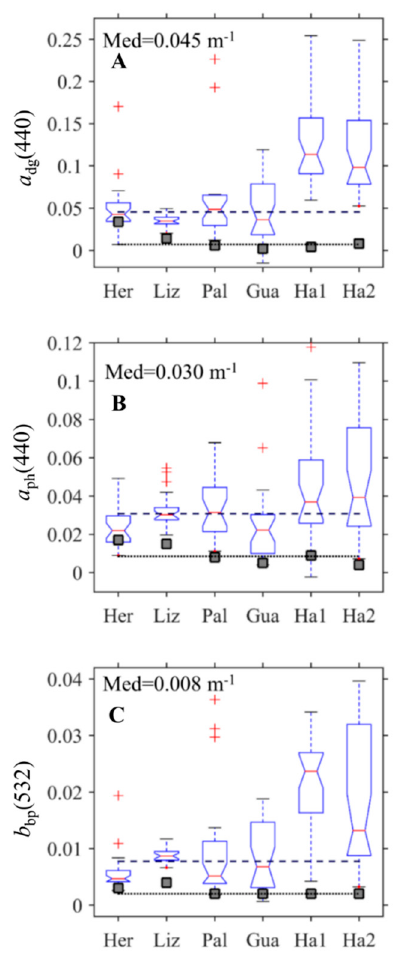
Figure 6. Boxplots of the optical properties measured at Heron Island (Her), Lizard Island (Liz), Palau (Pal), Guam (Gu), and Hawaii summer (Ha1) and Hawaii winter (Ha2) in comparison to MODIS imagery collected offshore for the same time period (gray squares) for ( A ) absorption by colored dissolved organic matter and non-algal particles at 440 nm ( a dg ); ( B ) absorption by phytoplankton at 440 nm ( a ph ); and ( C ) particulate backscattering at 532 nm ( b bp ). The median values are shown as lines and in text for all campaigns (Reef) and MODIS values (Offshore). Extreme outliers were removed for clarity.